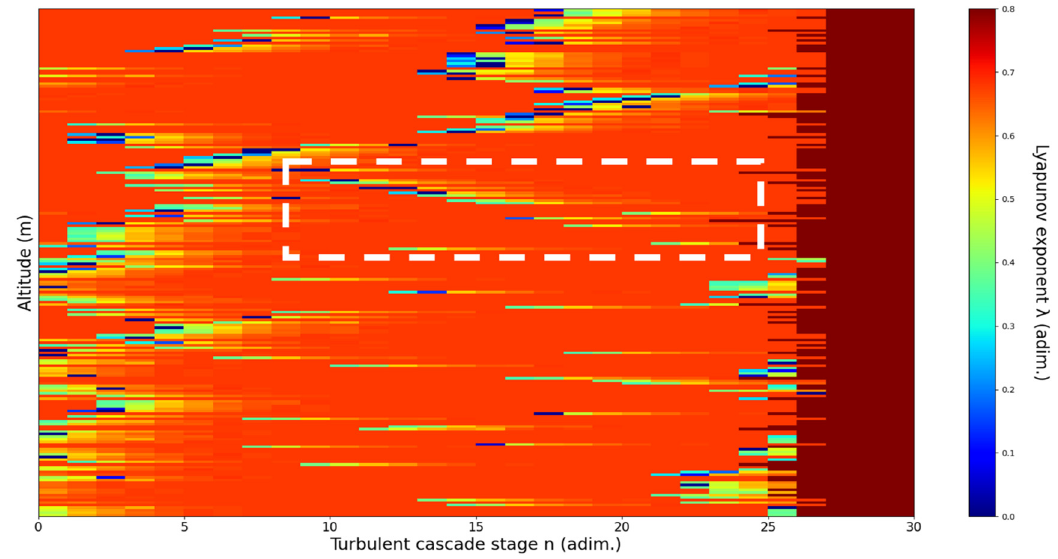
Figure 14. Lyapunov exponent per turbulent cascade stage colormap altitude plot, Bucharest, Romania, 13 June 2019,